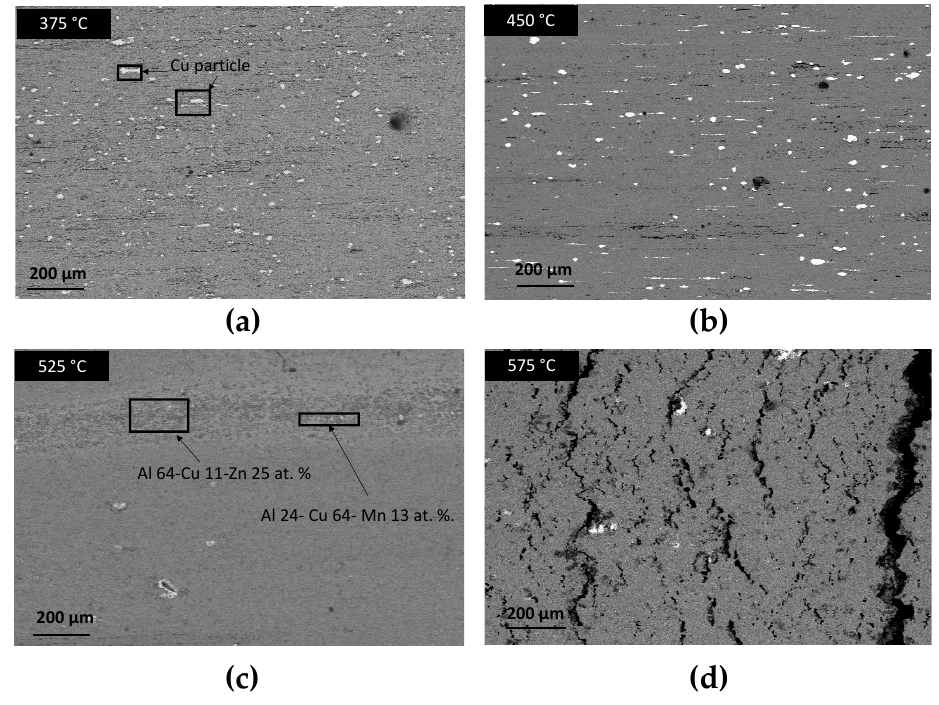
Figure 9. SEM images of the longitudinal section of bars from green compacts extruded at different temperatures: ( a ) 375 °C; ( b ) 450 °C; ( c ) 525 °C; ( d ) 575 °C.